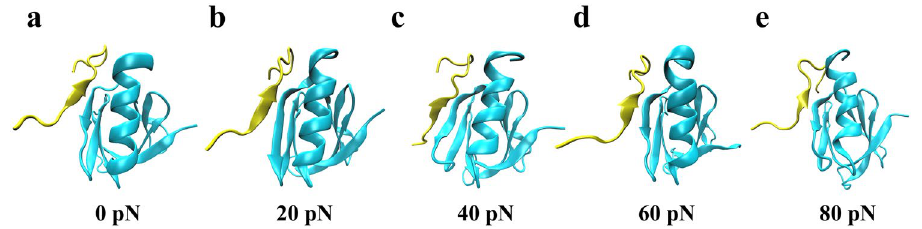
Figure 5. The structure snapshots of the clamped complex under constant tensile forces of 0.0 ( a ), 20 ( b ), 40 ( b ), 60 ( d ) and 80 pN ( e ). At each tensile force ≤ 80pN, unfolding did not occur in simulation, showing a fine mechanical stability and structural conservation of the complex. Each structural snapshot was taken from the samples at simulation time of 40 ns.